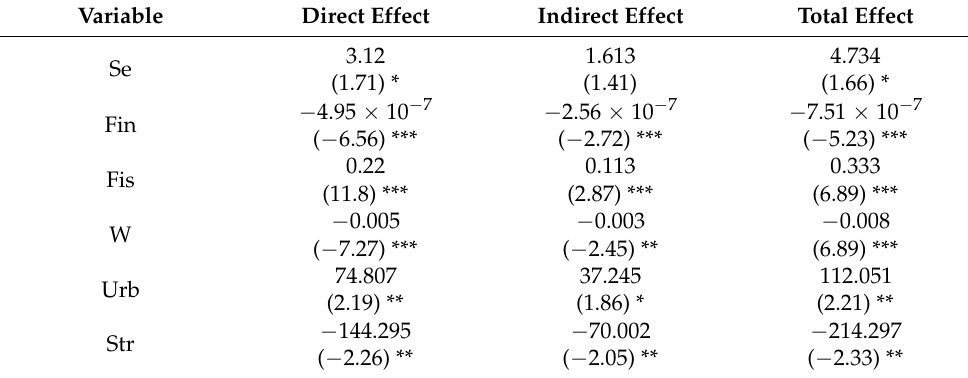
Table 4. Estimation results of decomposed spatial